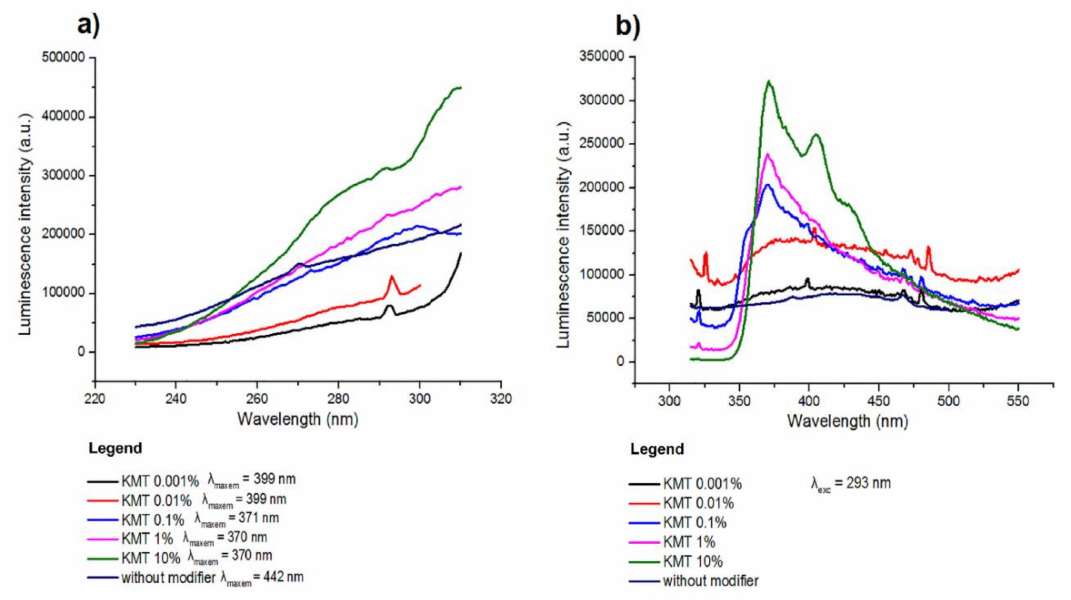
Figure 2. Excitation ( a ) and emission ( b ) spectra of fibers modified with luminescent polymer